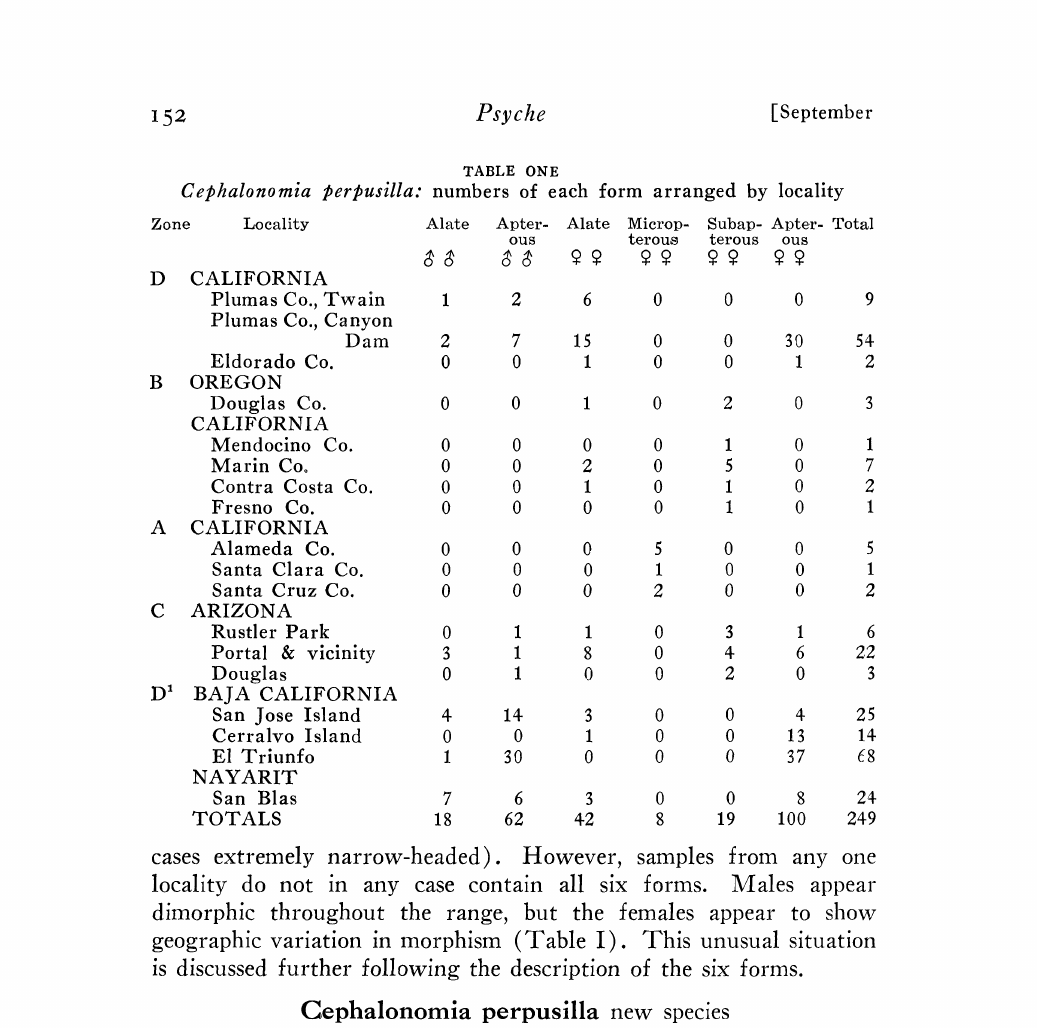
Cephalonomia perpusilla: numbers of each form arranged by locality